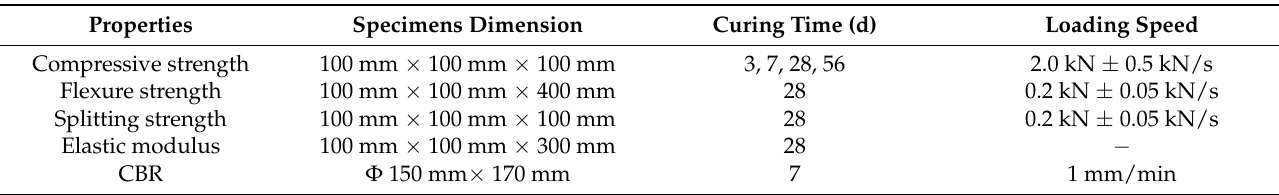
Table 3. Parameters for the performance test of the